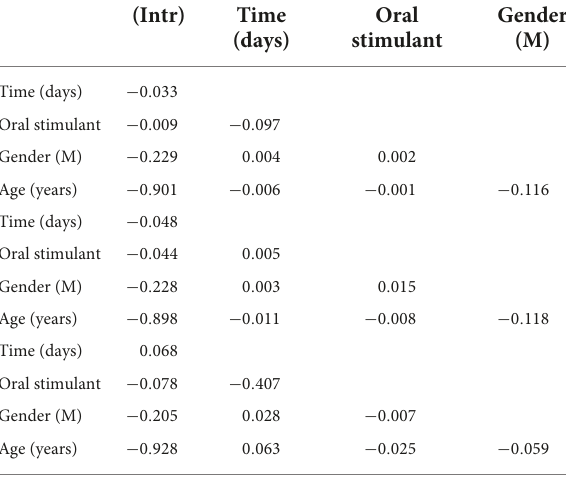
TABLE 3 Between covariate interclass correlation coefficient